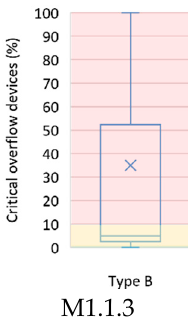
Figure 5. Results of the validation applied to the wastewater utilities: objective 1.